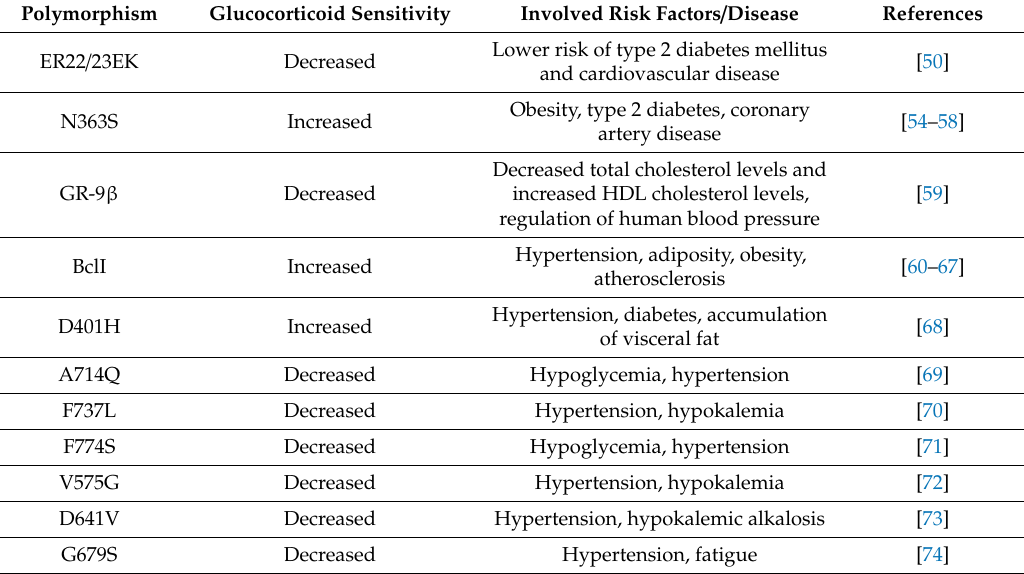
Table 1. Polymorphisms in the NR3C1 gene related to cardiovascular diseases